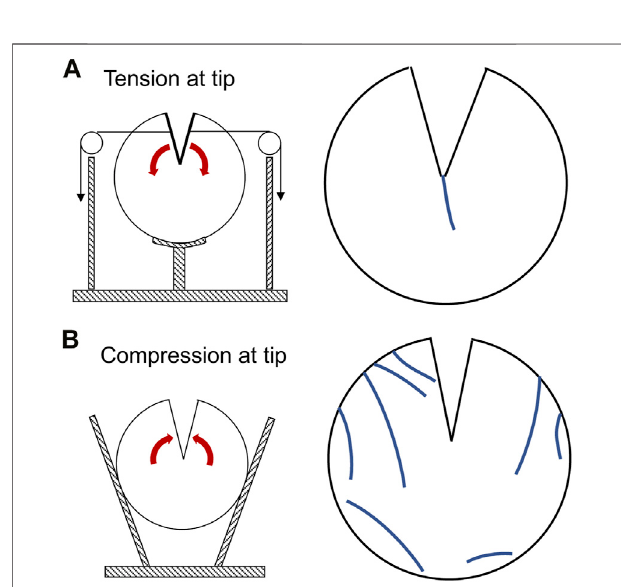
FIGURE 13 | Grain-displacive ice lens formation is affected by and eventually affectsthe local effective stress (Note: this observation applies to all fl uid-driven instabilities that affect fabric). (A) Ice lens nucleates and grows at the tip of the wedge when the tip is under tension. (B) Ice lenses grow at variouslocations at adistancefrom thetip when thetipisundercompression. Sketches on the left show the experimental con fi gurations (Yun, 2005).